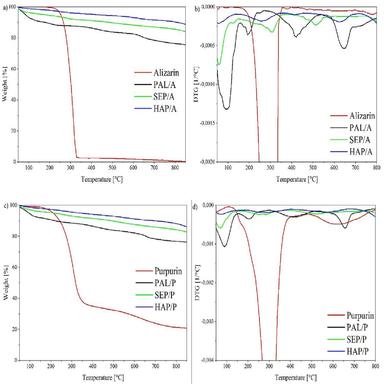
TGA/DTG curves for pure natural chromophores and hybrid pigments prepared from (a,b) alizarin and (c,d) purpurin.